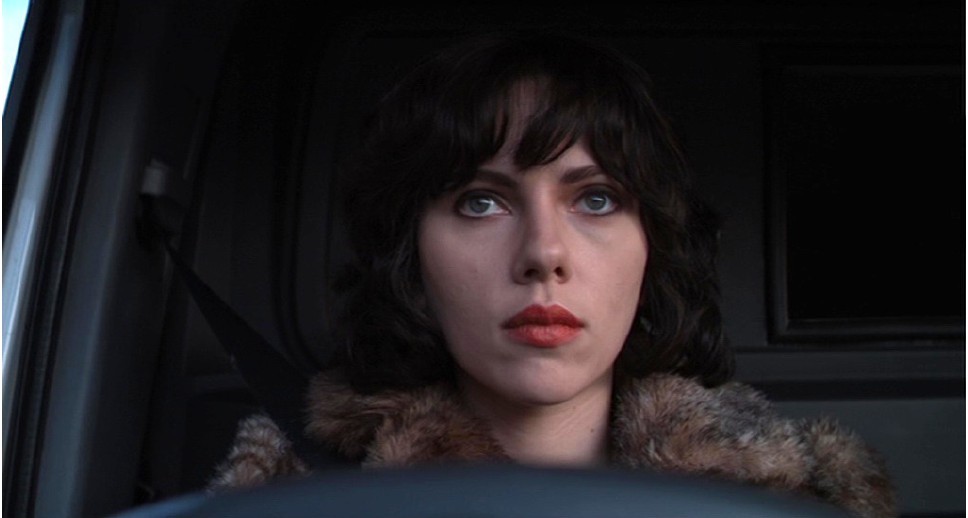
Figure 1: Scarlett Johansson in Under the Skin directed by Jonathan Glazer. 2013; London: BFI & Film 4.